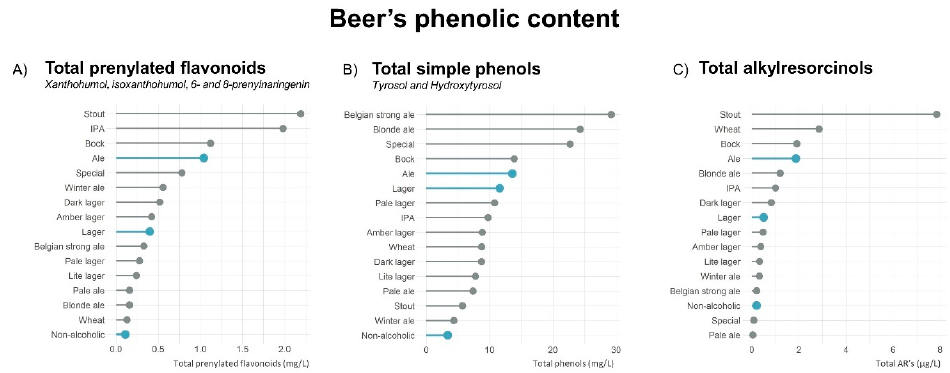
Figure 2. Beer’s phenolic content ( A ) total prenylated flavonoids, ( B ) total simple phenols and ( C ) total alkylresorcinols distributed by beer type (blue) in ale ( n = 18); lager ( n = 22) and non-alcoholic ( n = 5) and in beer styles (grey) in amber lager ( n = 2); Belgian strong ale ( n = 3); blonde ale ( n = 2); bock ( n = 1); dark lager ( n = 1); IPA ( n = 6); lite lager ( n = 1); pale ale ( n = 1); pale lager ( n = 15); special